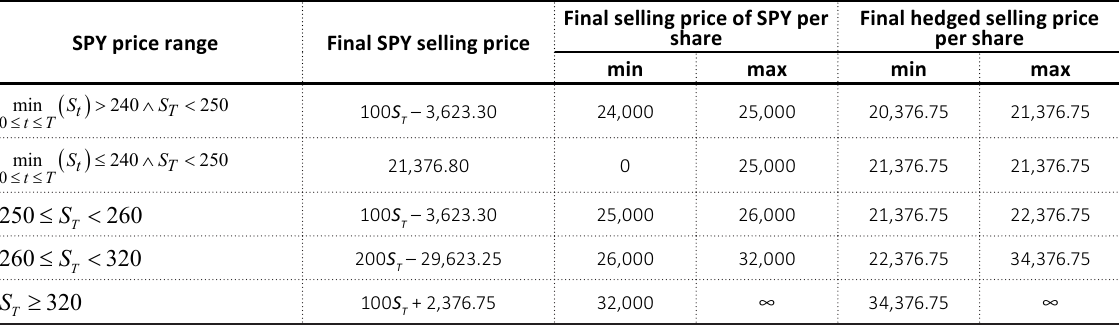
Table 8. Final selling prices using Short Put Ladder option strategy_1A